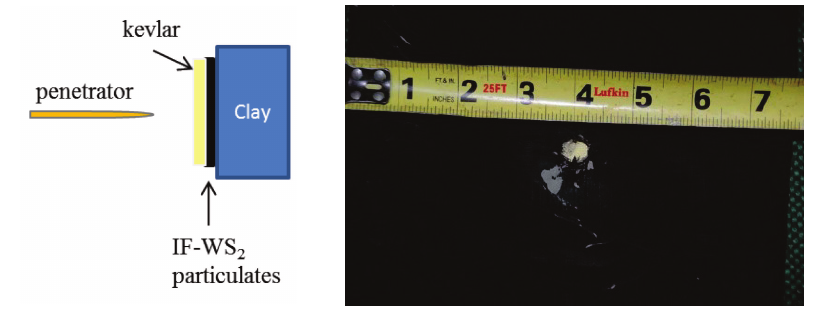
Figure 12. Sample testing setup ( left ) and orifice left by penetrator in a nylon bag that contained the sample in between Kevlar layers ( right